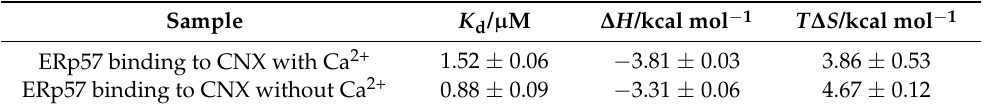
Figure 2. Thermodynamic characterization of effects of Ca 2+ on the interaction between ERp57 and CNX. The ITC data show the titration of ERp57 against CNX in the presence ( a ) and absence ( b ) of Ca 2+ . Thermodynamic parameters for ERp57 binding to CNX are compiled in Table 1. The error values obtained from the model fitting were shown in Table 1. Table 1. Thermodynamic parameters for ERp57 binding to CNX with/without Ca 2+ . K d , H , T , and S mean binding dissociation constant, enthalpy, temperature and